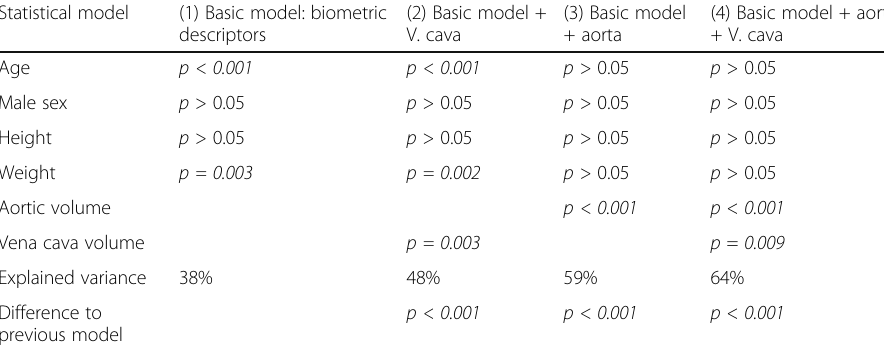
Table 4 Statistical significance of confounding variables for GEDV Statistical